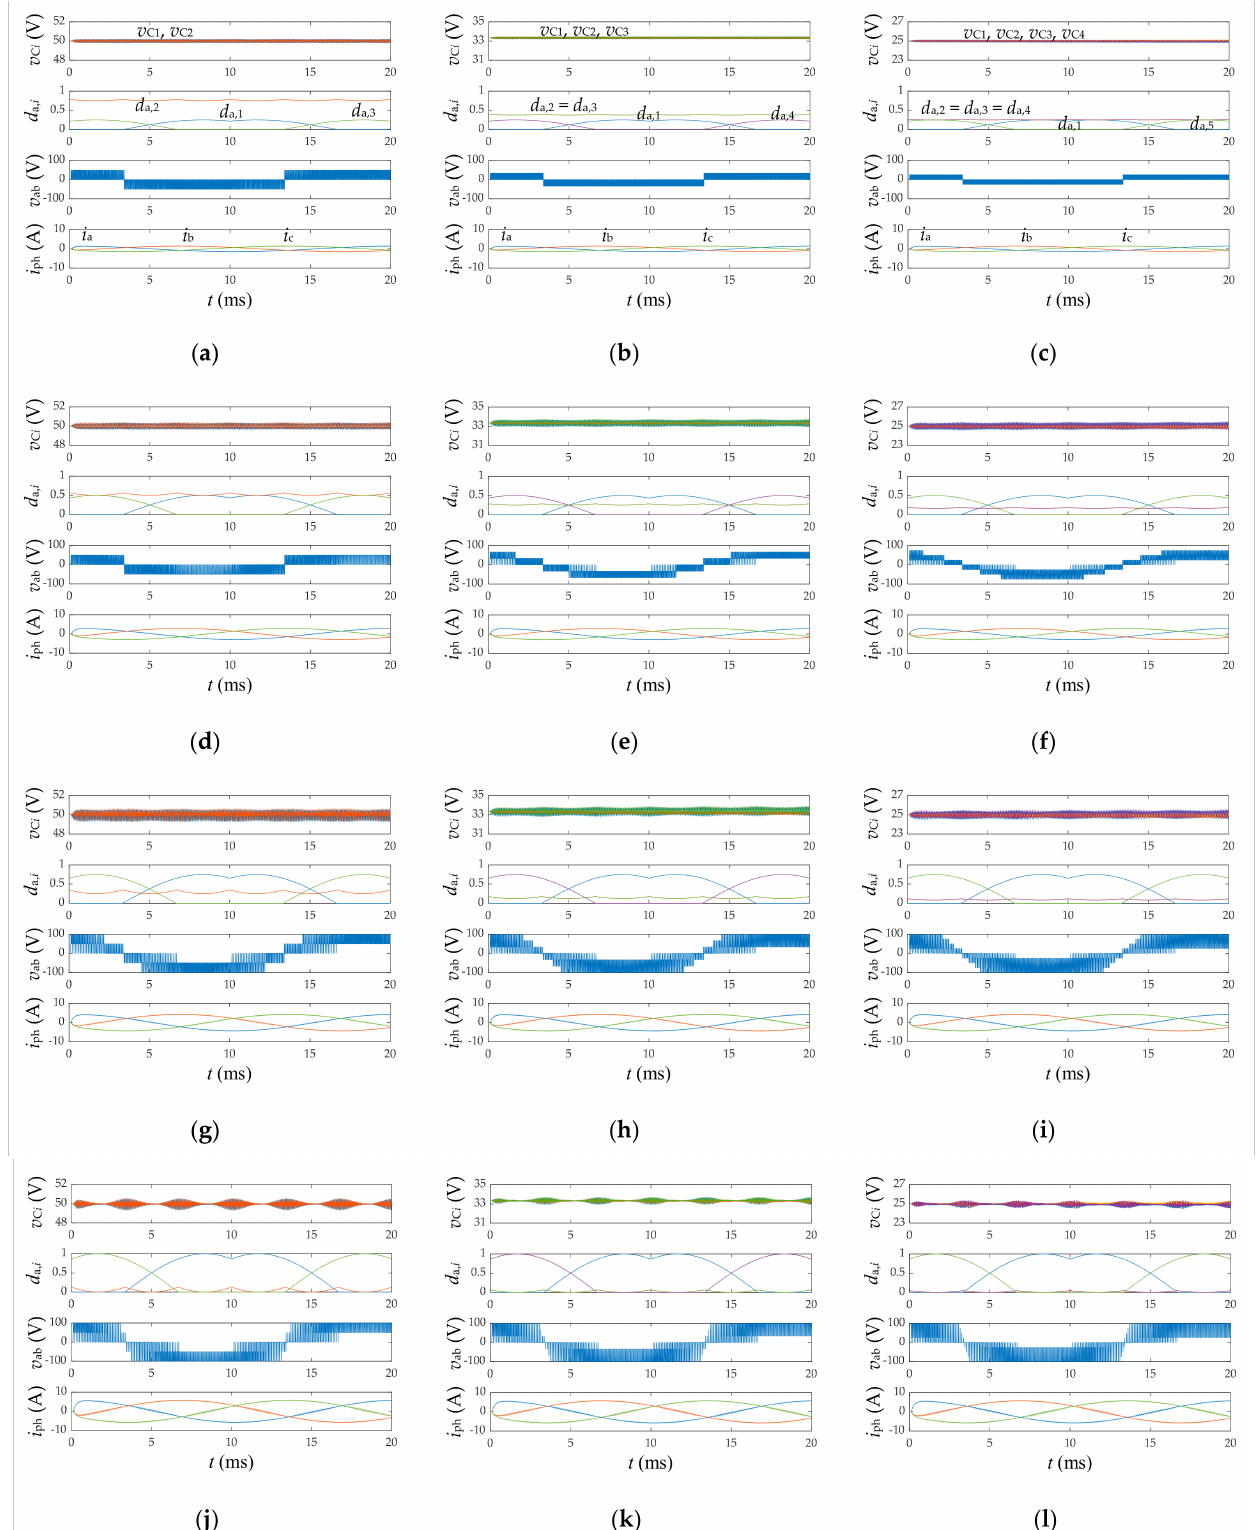
Figure 6. Simulation results for the three-phase NPC DC–AC conversion system of Figure 4, operated with the proposed VVPWM strategy formulation, under different modulation index values m and numbers of levels n in the undermodulation range ( hbc = 1). ( a ) m = 0.25, n = 3; ( b ) m = 0.25, n = 4; ( c ) m = 0.25, n = 5; ( d ) m = 0.5, n = 3; ( e ) m = 0.5, n = 4; ( f ) m = 0.5, n = 5; ( g ) m = 0.75, n = 3; ( h ) m = 0.75, n = 4; ( i ) m = 0.75, n = 5; ( j ) m = 1, n = 3; ( k ) m = 1, n = 4; ( l ) m = 1, n =